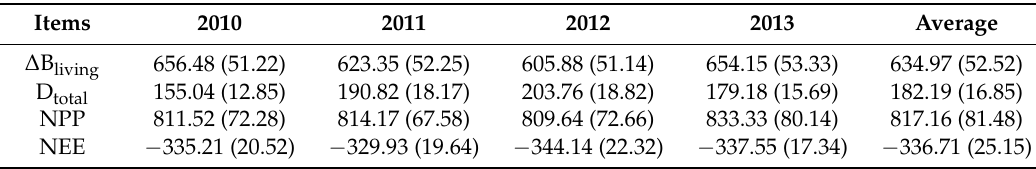
Table 5. Annual net primary productivity (NPP) and net ecosystem exchange (NEE) during 2010–2013 (g · C · m − 2 · y − 1 ).